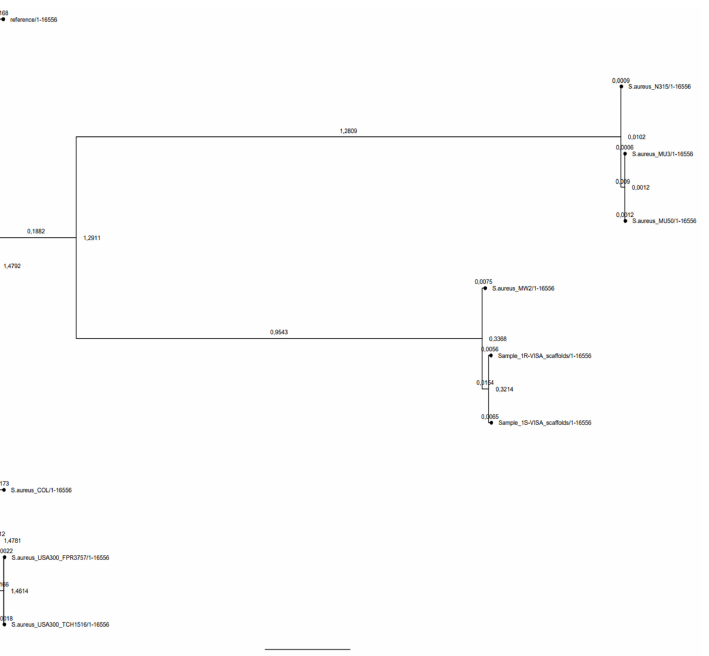
Figure 1. Phylogenetic SNP tree of 1-S and 1-R versus a representative group of HA-MRSA (Reference:SA-NCTC8325, SA-COL, SA-Mu3,SA-Mu50,SA-N315), and CA-MRSA (SA-USA-300 FPR3757, SA-USA-300TCH 1516, SA-MW2 USA-400).